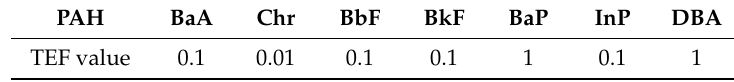
PAH BaA Chr BbF BkF BaP